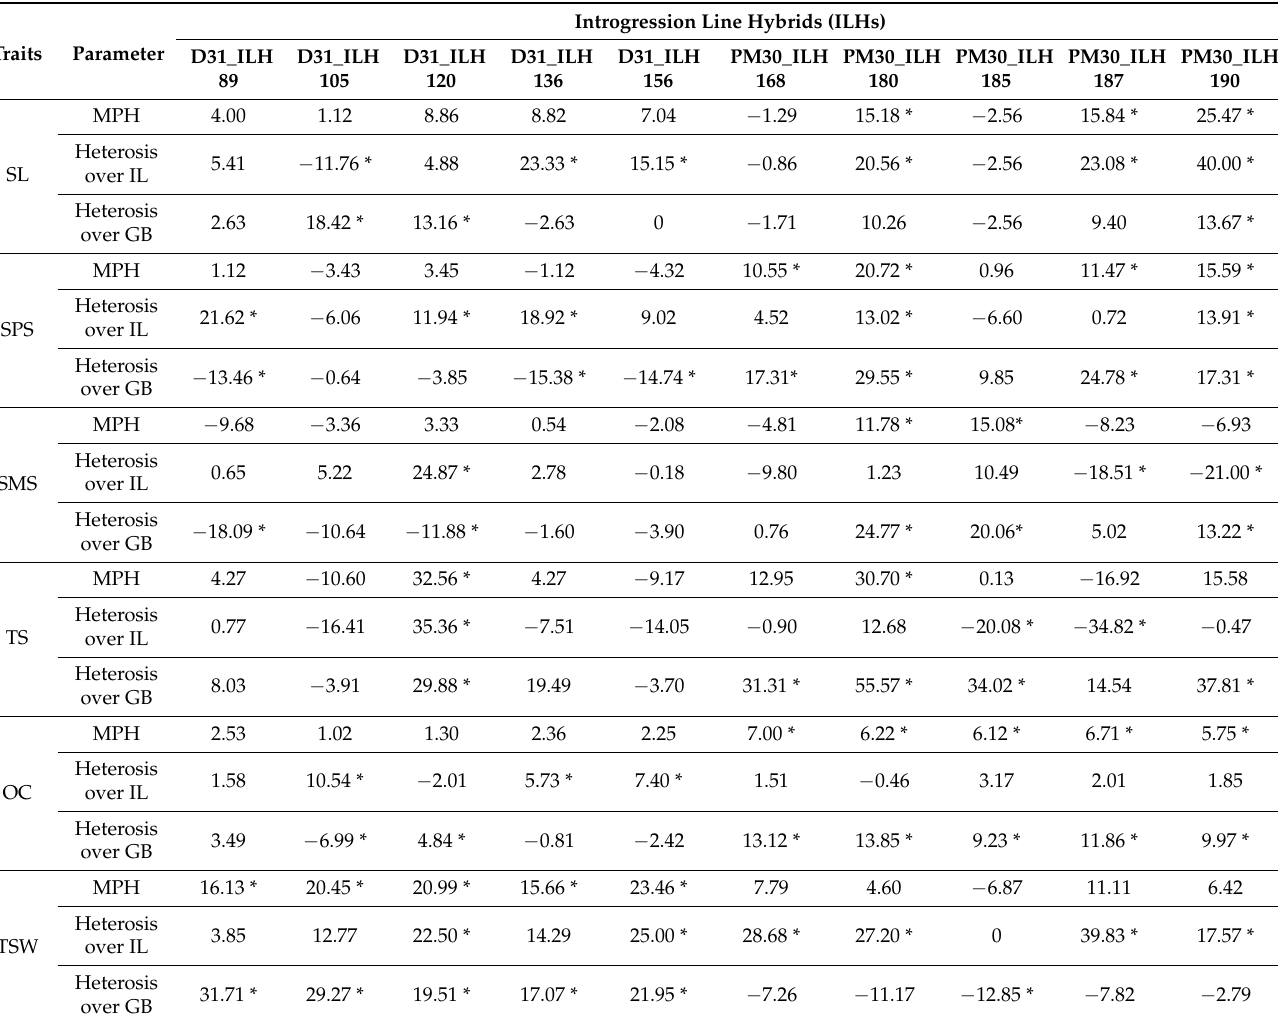
Table 4. Extent of heterosis (%) over mid-parent, respective introgression lines and genetic back- grounds for seed yield and its contributing traits in 10 Introgression Line Hybrids